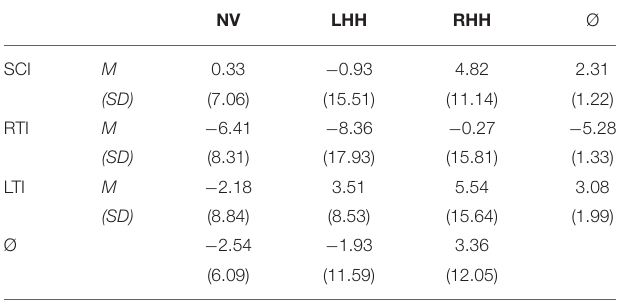
TABLE 3 | Mean and standard deviation of mean gaze eccentricity per vision condition and intersection